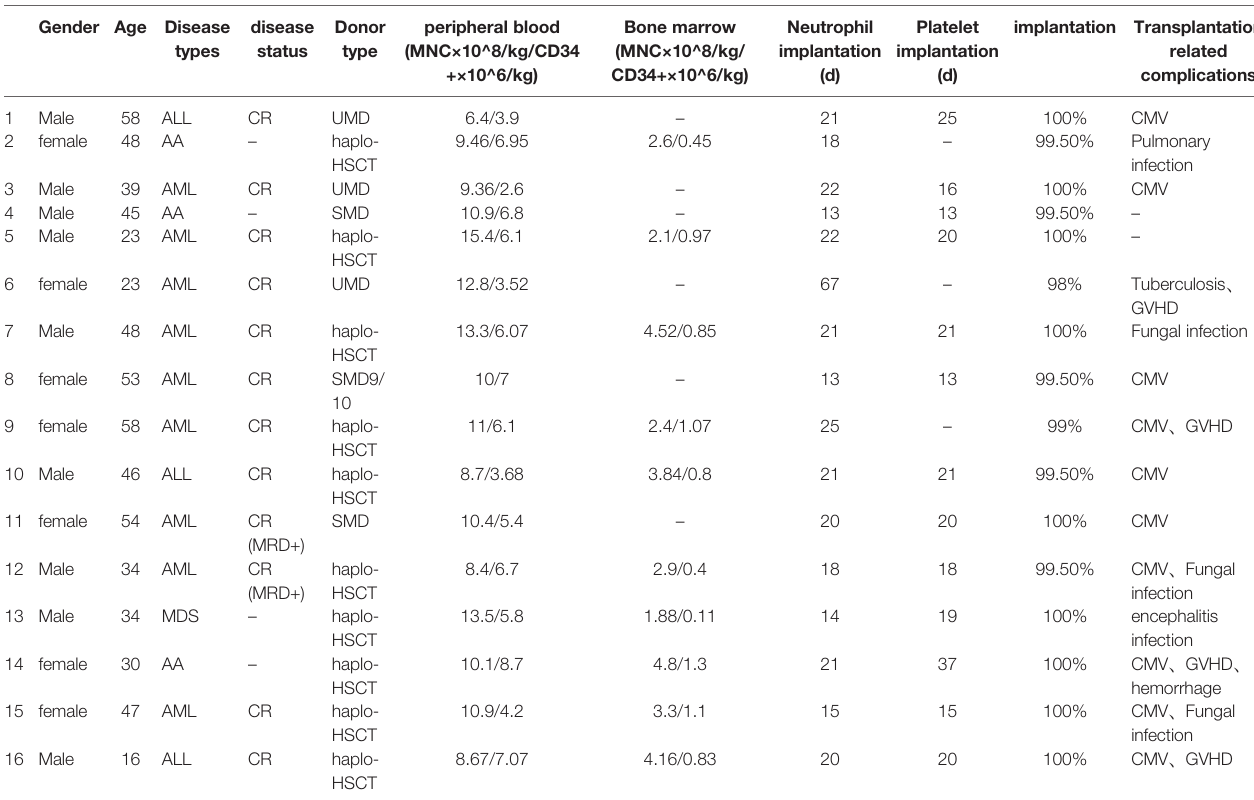
TABLE 1 | Patients clinical characteristics (n = 16). Gender Age Disease disease types